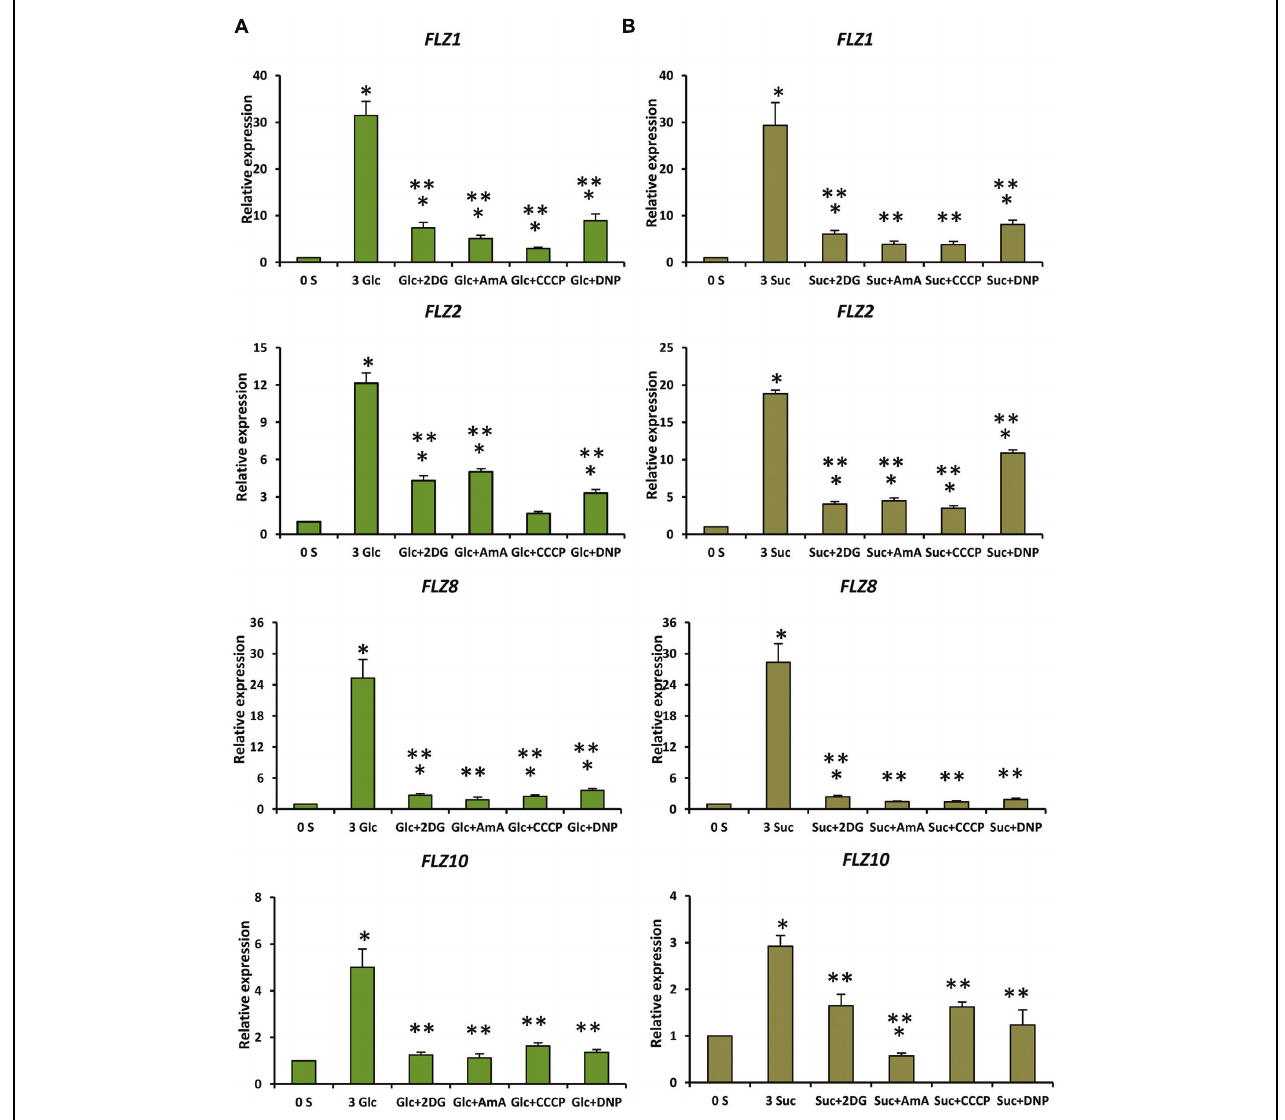
FIGURE 4 | Involvement of energy signaling in the regulation sugar-dependent up-regulation of FLZ genes. The effect of metabolic inhibitors on the sugar-mediated transcriptional up-regulation of FLZ genes was studied by qRT-PCR. (A) The effect of metabolic inhibitors on the glucose-sensitivity of FLZ genes. (B) The effect of metabolic inhibitors on the sucrose-sensitivity of FLZ genes. The expression in 0% sugar grown plants was taken as the control for comparing the expression in 3% sugar treatment alone or with metabolic inhibitors. UBQ10 was used as endogenous control. The bars represent the average of two independent biological experiments with three technical replicates each and error bars represent SE. Single asterisk indicates a significant difference of expression in the treatment compared to control 0% sugar. Double asterisk indicates a significant difference of expression in the treatment compared to 3% Glc or 3% Suc ( P < 0.005, Student’s t